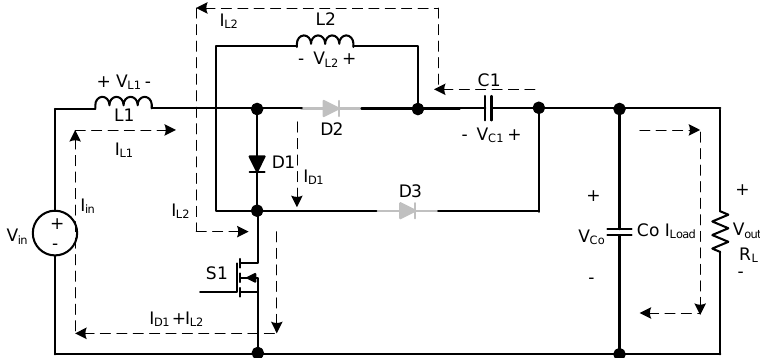
Figure 2. Voltage polarities and current directions in Mode 0.